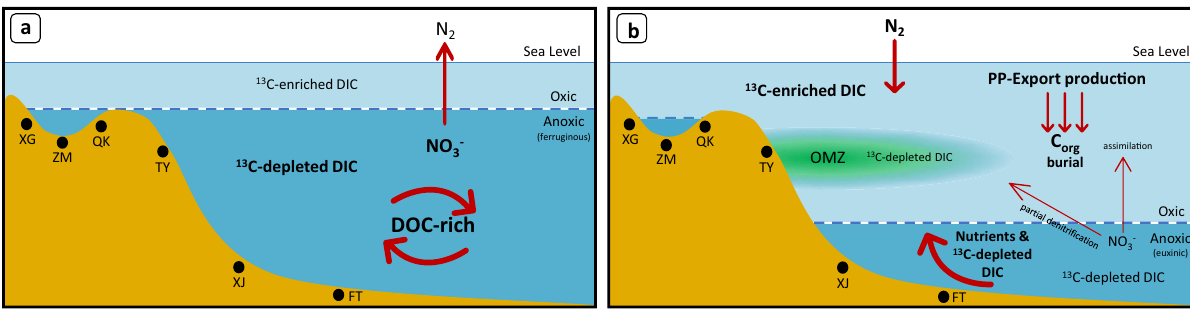
Fig. 4 Schematic diagram showing the biogeochemical evolution of the late Ediacaran ocean. a During the Shuram excursion, denitri fi cation was the dominant N biogeochemical process. Recycling and remineralization of DOC by heterotrophic organisms led to a 13 C − depleted rich DIC pool. Anoxic waters were predominantly ferruginous 23,34 . b During the recovery from the Shuram excursion N 2 - fi xation became the main N biogeochemical process. Extensive PP in shallow waters favored the increase of organic carbon fl uxes towards deep waters and the 13 C − enriched DIC budget, which counteracted the 13 C − depleted DIC pool and led to positive shifts in δ 13 C carb and δ 13 C org . Anoxic waters were predominantly euxinic 23 . XG Xiangerwan, ZM Zhimaping, QK Qinglinkou, TY Taoying, XJ Xiajiaomeng, FT Fengtan. DOC dissolved organic carbon, DIC dissolved inorganic carbon, PP Primary production, OMZ Oxygen Minimum Zone. Text in bold represents the dominant